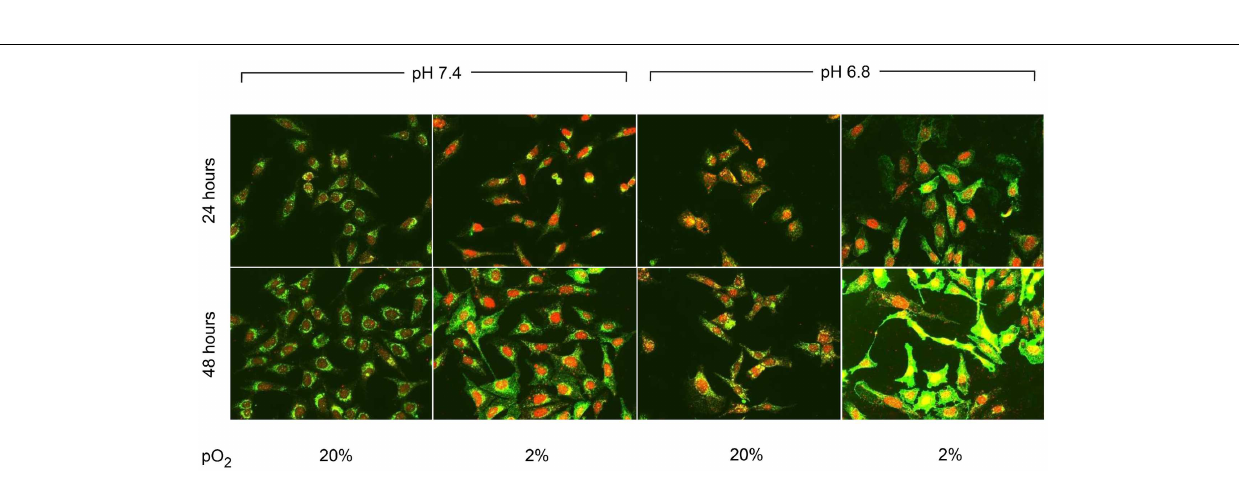
Frontiers in Oncology | Pediatric